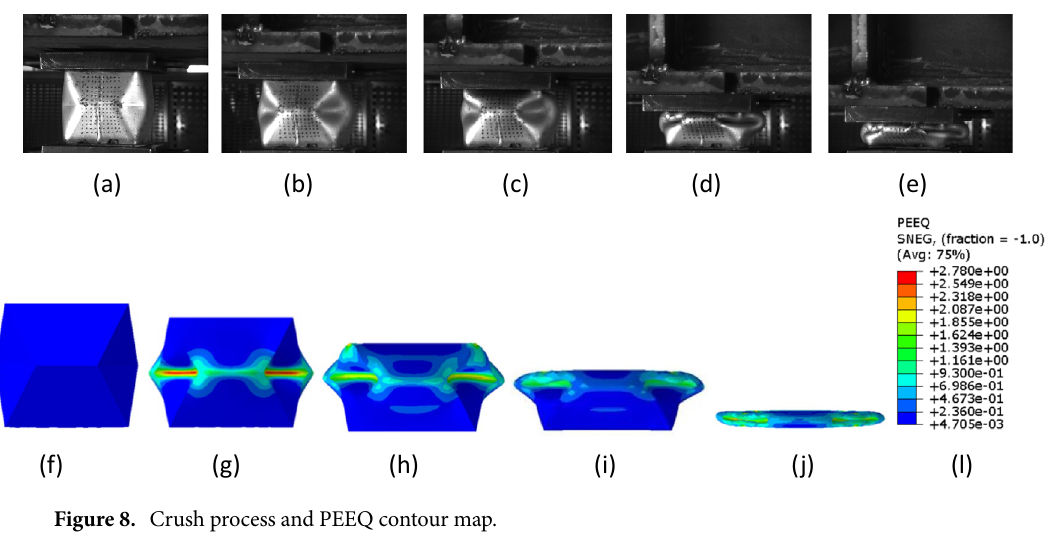
Figure 8. Crush process and PEEQ contour